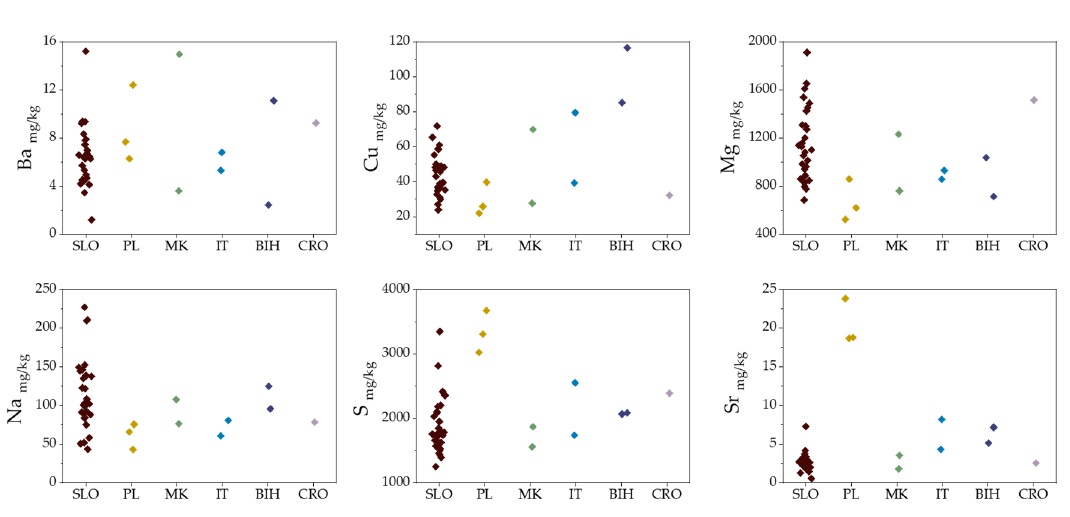
Figure 2. Column scatter plots of element contents in T. aestivum from different geographical regions: SLO (Slovenia), PL (Poland), MK (North Macedonia), IT (Italy), BIH (Bosnia and Herzegovina), CRO (Croatia).